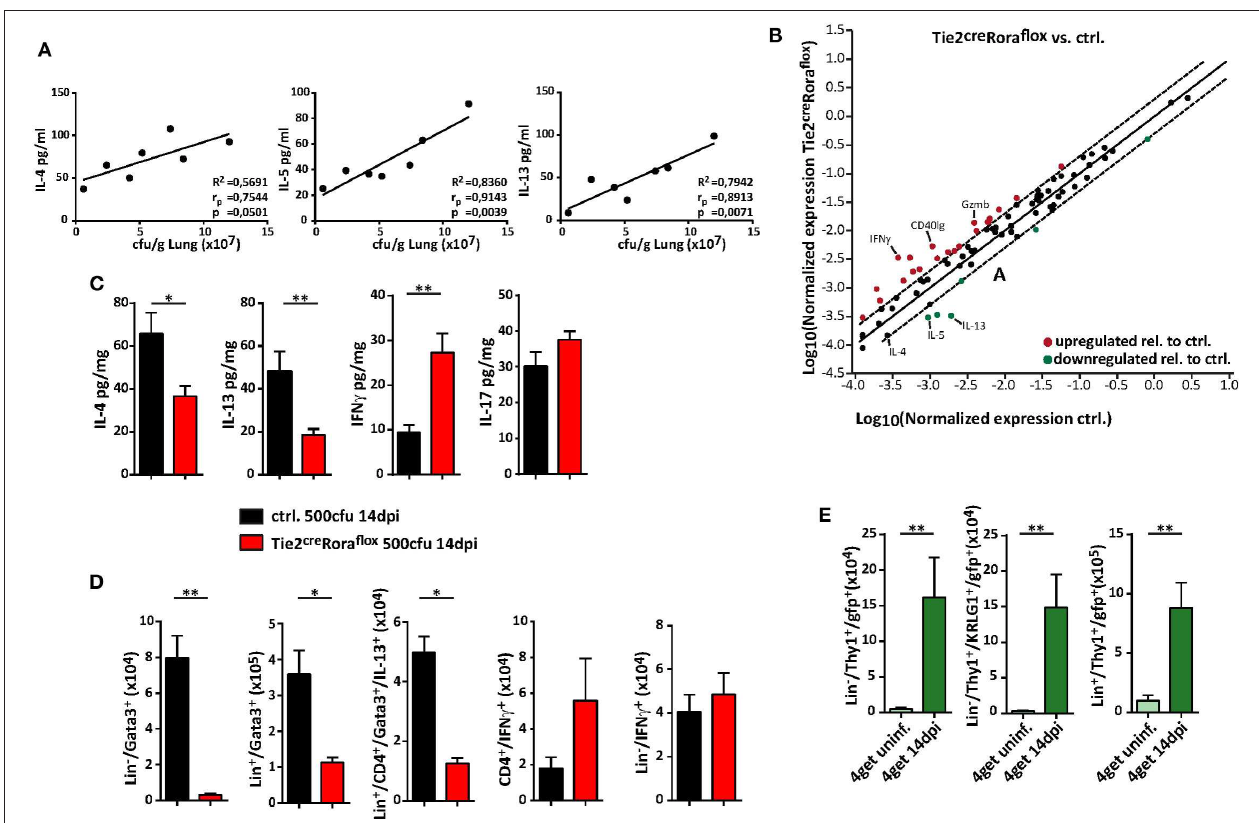
FIGURE 4 | ILC2 orchestrate the local pulmonary cytokine milieu during cryptococcosis. (A–D) Control and (B–D) conditional Rora deficient mice (Tie2 cre Rora flox ) were subjected to intranasal C. neoformans infection (500 cfu infection dose) for 14 days. (A) Correlation analysis of cytokine concentrations (IL-4, IL-5, and IL-13) with fungal burden ( n = 7). (B) Scatter plot of differentially regulated genes in Tie2 cre Rora flox compared to control mice. Data was generated by using RT 2 Profiler PCR Array PAMM-074 (Qiagen) and relative gene expression was analyzed in the web-based Qiagen Data Analysis Center. Boundaries mark threshold of 2-fold change ( n = 4, pooled/group). (C) Total lung protein concentrations of IL-4 (ctrl. n = 11; Tie2 cre Rora flox mice n = 18), IL-5 (ctrl. n = 9; Tie2 cre Rora flox mice n = 14), IFN γ (ctrl. n = 9; Tie2 cre Rora flox mice n = 14) and IL-17 (ctrl. n = 11; Tie2 cre Rora flox mice n = 18) was quantified in response to C. neoformans infection. (D) Lung single cell preparations were stimulated with PMA/ionomycin in the presence of protein transport inhibitors for 4h. Cell numbers of Lin − /Gata3 + ILC2, Lin + /Gata3 + cells, Lin + /CD4 + /Gata3 + /IL-13 + T cells, CD4 + /IFN- γ + T cells, and Lin − /CD4 − /IFN- γ + ILC1 determined in lung tissue of infected mice (ctrl. n = 8; Tie2 cre Rora flox mice n = 11). (E) Analysis of naïve or C. neoformans infected (14 dpi) 4get mice. Data is presented as mean ± SEM (A) representative of two experiments, (B) one experiment or (C–E) pooled from 2 to 3 experiments. * P ≤ 0.05; ** P ≤ 0.01 defined by Mann-Whitney U